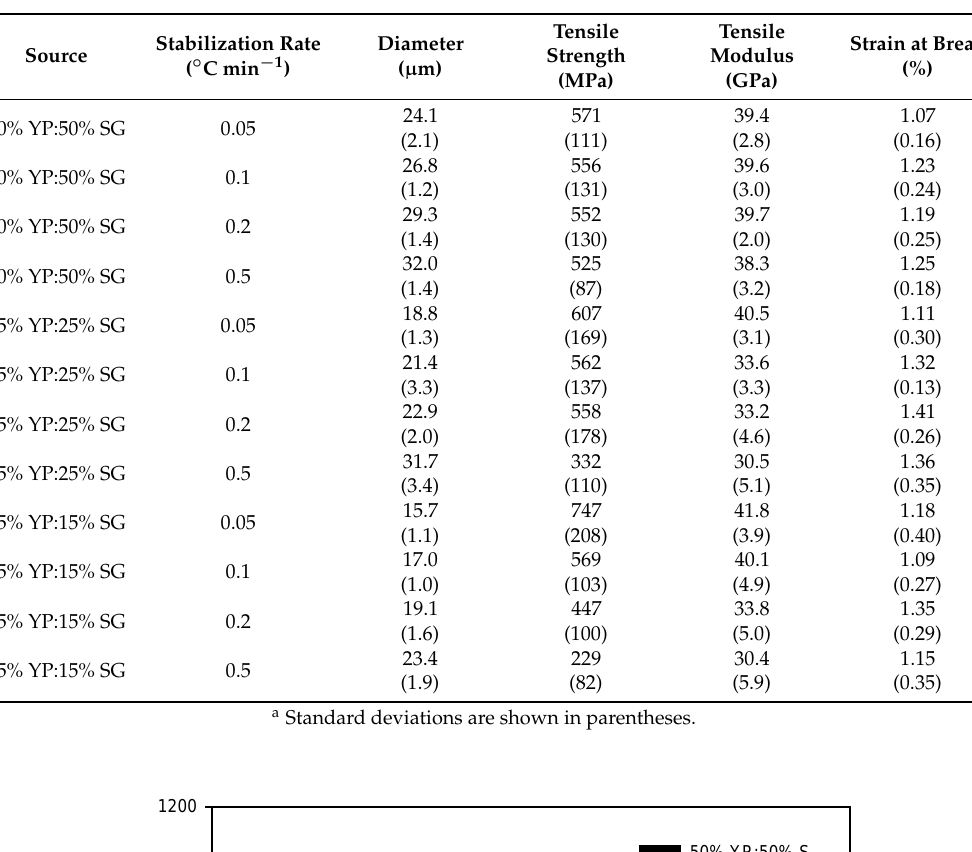
Table 6. Mechanical properties of carbon fibers made from different ratios of switchgrass and yellow poplar lignin blend a .